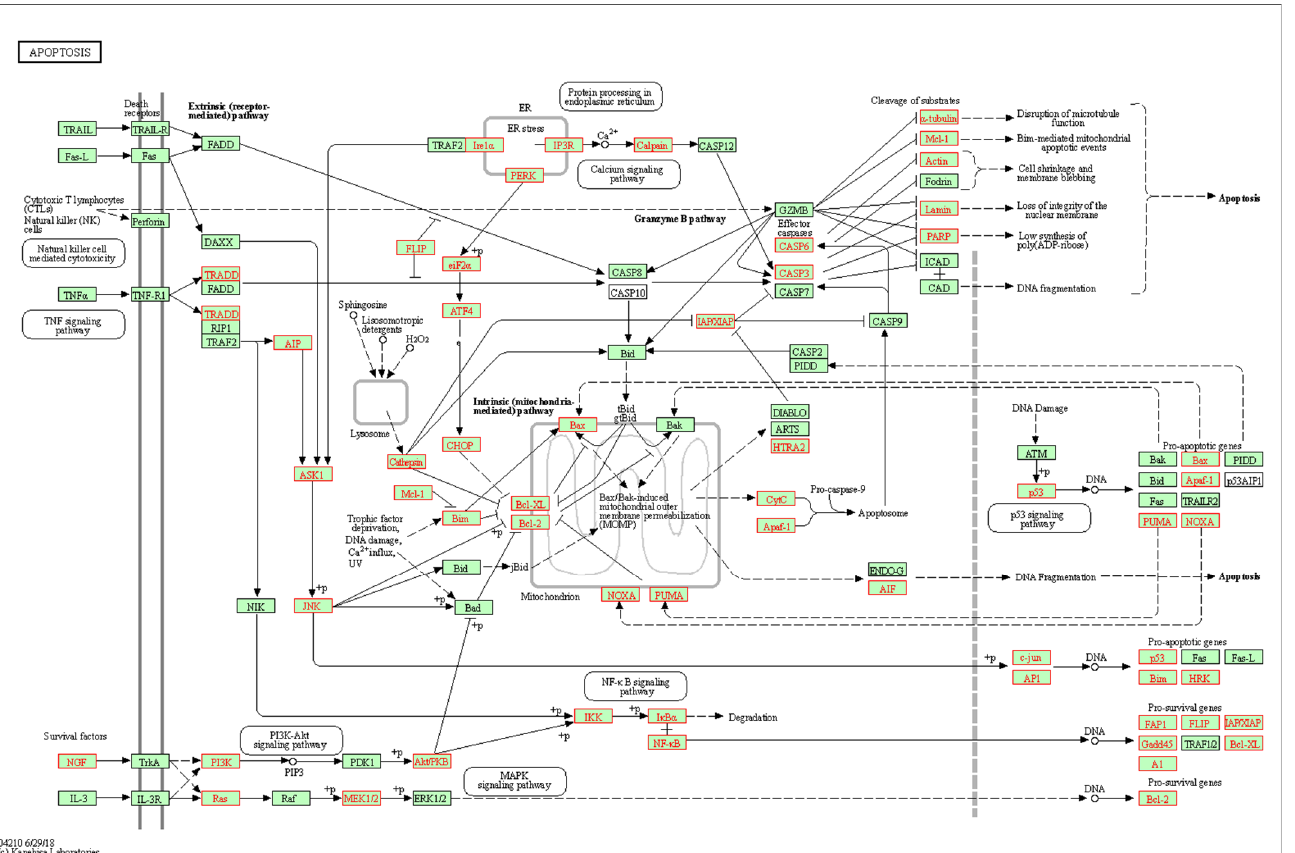
Figure 4. Differential ethanol-induced gene expression changes related to Apoptosis signaling. Over 50% of the genes in the KEGG Apoptosis Signaling pathway (mmu04210) showed a significant ( adjp < 0.05) strain × treatment interaction (n = 73, total in pathway = 136). Differential ethanol-induced gene expression changes are shown in red font. Enrichment analysis was performed using tools available at WebGestalt (www.webgestalt.org), with FDR adjp < 0.05.